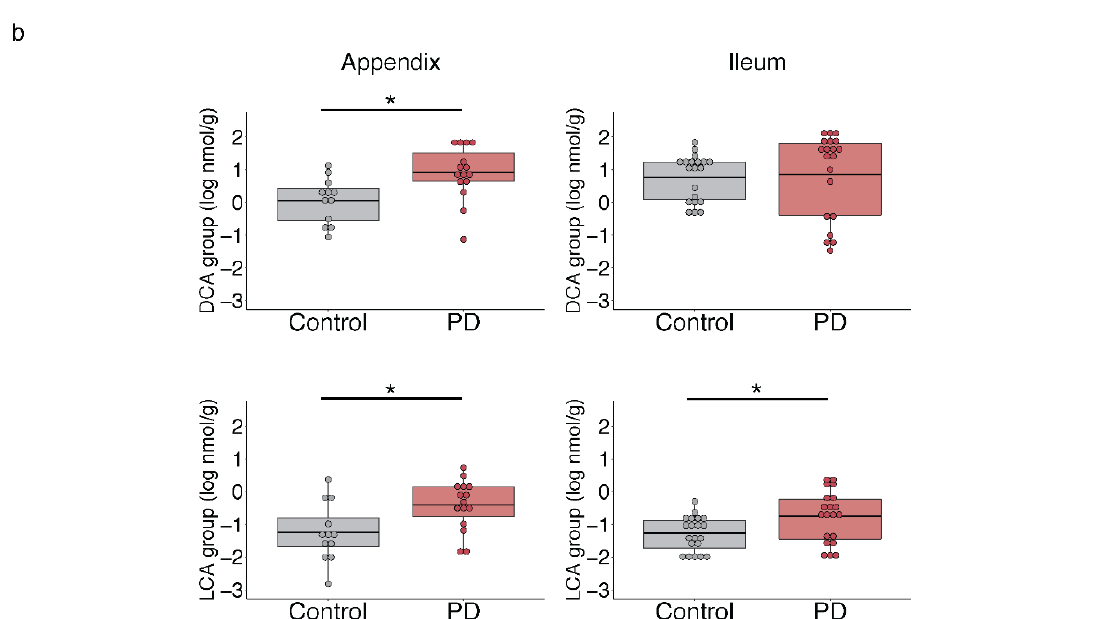
Figure 3. Increase in the microbiota-derived secondary bile acids in the appendix of PD patients. Bile acid analysis was performed by liquid chromatography–mass spectrometry in the PD and control appendix ( n = 15 PD, 12 controls) and ileum ( n = 20 PD, 20 controls). Bile acid changes were determined by robust linear regression, controlled for age, sex, and postmortem interval. ( a ) Illustration of the bile acid changes identified in this study and the bile acid pathway. Primary bile acids are generated in the liver and secondary bile acids are produced by microbiota in the intestine. In the secondary bile acid section of the image, boxes highlight the DCA and LCA groups (DCA, LCA and their respective conjugates). Bile acids increased in the PD appendix or PD ileum, relative to controls, are marked by a blue and green arrow, respectively. The flame symbol denotes hydrophobic bile acids that have proinflammatory effects when elevated. ( b ) Secondary bile acid changes in the PD appendix and PD ileum. The boxplot center line represents the mean, the lower and upper limits are the first and third quartiles (25 th and 75 th percentiles), and the whiskers are 1.5× the interquartile range. * p < 0.05, robust linear regression.